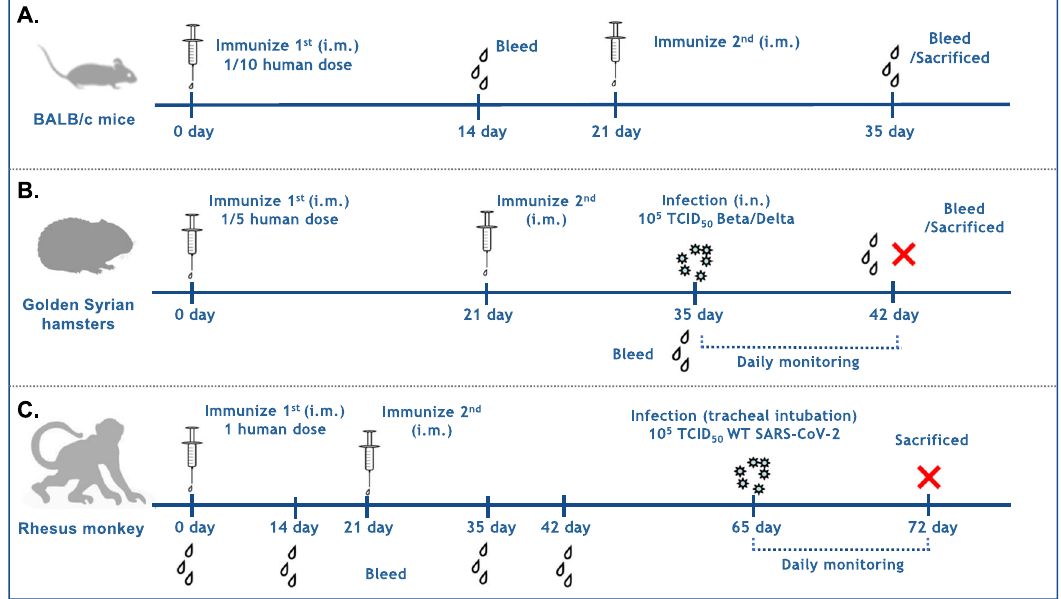
Fig. 2 Experimental schedule. A BALB/c mice were immunized twice intramuscularly at Day 0 and Day 21. On Day 35, blood was collected to perform serological assays (SAs) ( N = 10). On Day 35, 5 mice from each groups were sacri fi ced to conduct intracellular staining (ICS) assay and ELISPOT ( N = 5). B Hamsters were immunized intramuscularly at Day 0 and Day 21 ( N = 6). Blood was collected at Day 35 from each group to detect antibody responses. On Day 42, all hamsters were challenged intranasally with 10 5 TCID 50 of Beta strain or Delta strain. On Day 49, a subset of hamsters in each group was euthanized for detecting viral loads of lungs and nasal turbinates by qRT-PCR and evaluating lung histopathology by hematoxylin and eosin (H&E) staining. C Rhesus macaques were immunized twice intramuscularly at Day 0 and Day 21 ( N = 6). Blood was collected at Day 0, Day 14, Day 28 and Day 35 to perform serological assays (SAs). In addition, PBMCs were isolated at Day 35 to detect cellular immune responses by intracellular cytokine staining (ICS) and ELISPOT. On day 65, all the rhesus macaques were challenged with 1 × 10 5 TCID 50 SARS-CoV-2 by tracheal intubation. After challenged, the body weight, temperature and viral load of throat, nasal, anal and blood swabs were daily monitored. On day 72, rhesus macaques were euthanized for detecting viral loads of lungs